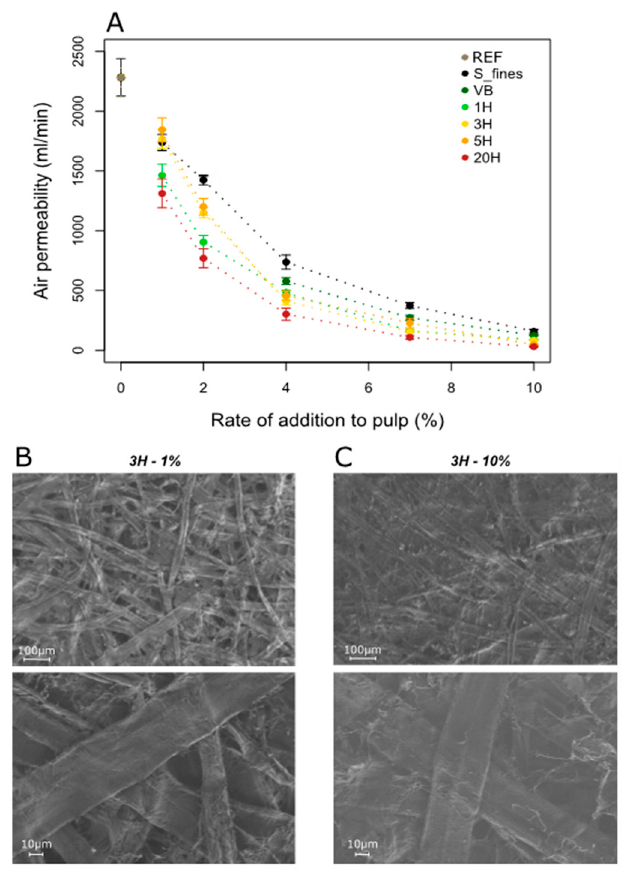
Figure 7. ( A ) Influence of the nature and quantity of the different additives on paper air permeability measurements; ( B , C ) SEM images of the topography of composite handsheets realized with 1% and 10% of 3H (magnification 100 × on the top image and 500 × on the bottom image, with an acceleration voltage of 0.65 kV).